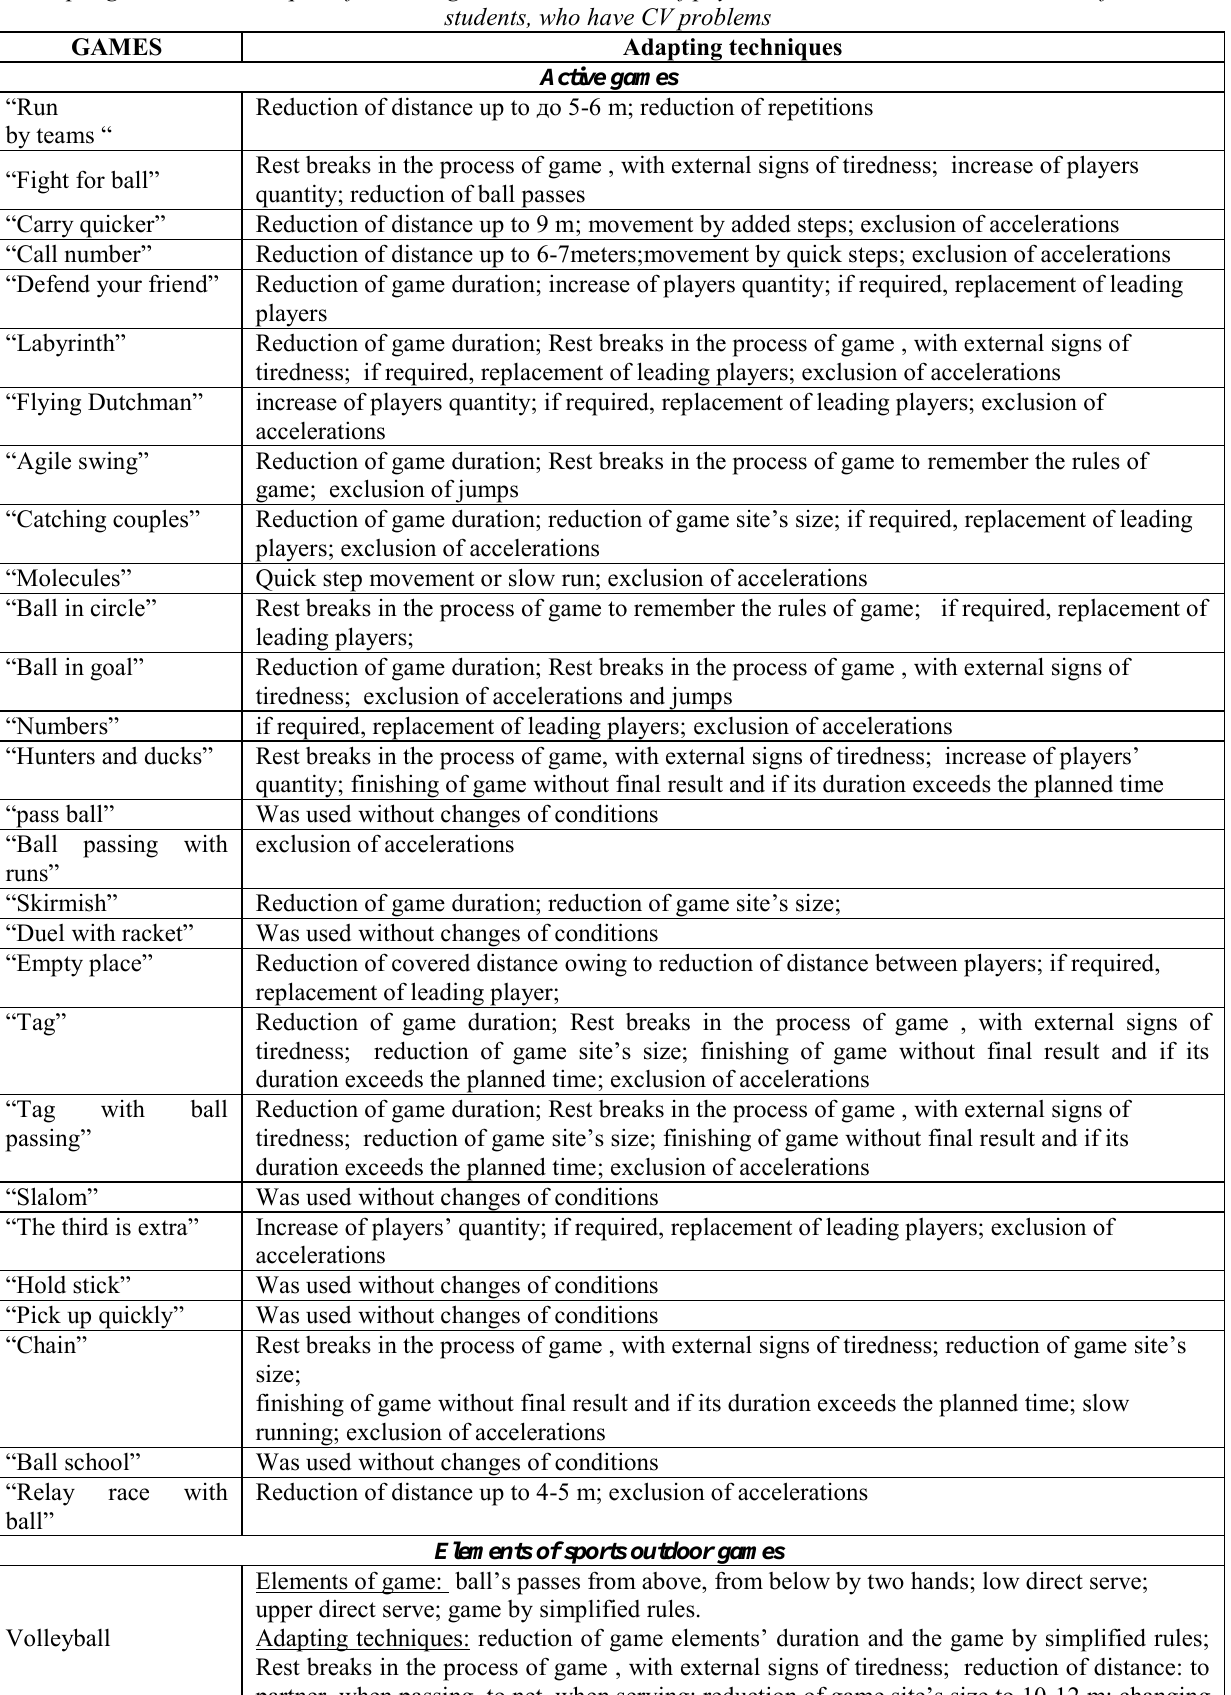
Adapting methodic techniques of outdoor games and indicators of physical loads, which are recommended for